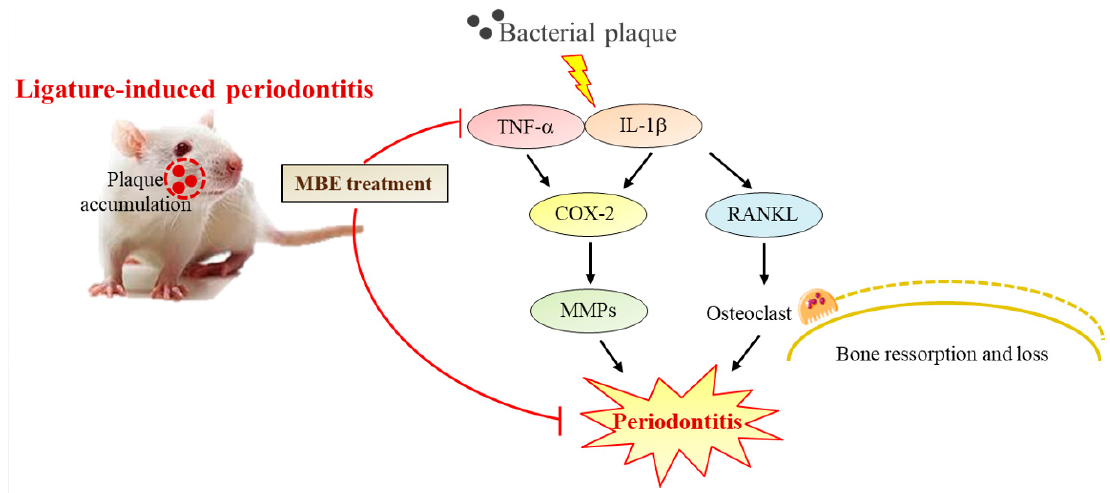
Figure 5. The proposed mechanism of Magnolia biondii extract’s antiperiodontitis effects.